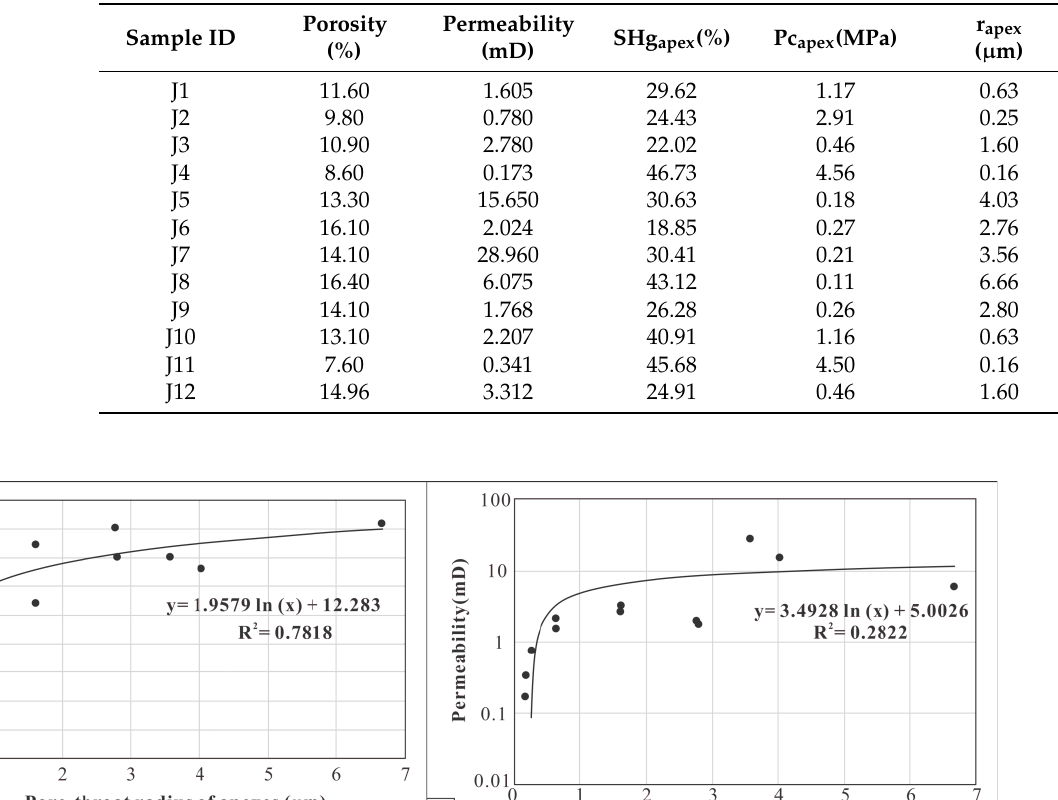
Table 4. Parameters of the Pittman plot calculation for the 12 typical samples.